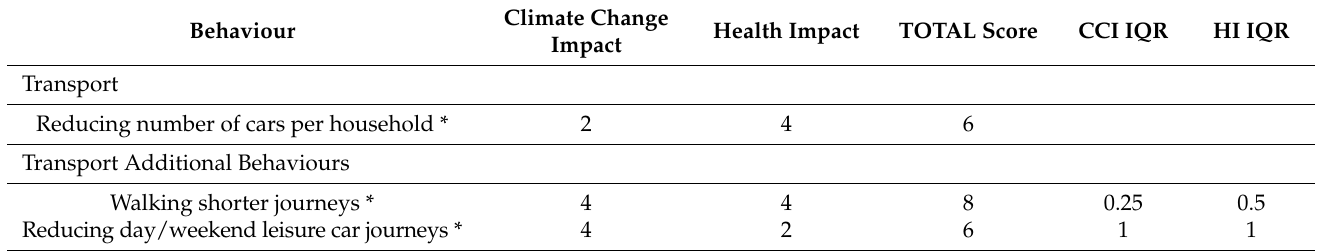
Table 4. Climate change mitigation behaviours that achieved consensus in Round 3 (including additional behaviours), climate change impact Likert importance scores, health impact criteria Likert importance scores, cumulative importance scores (TOTAL score), climate change impact IQR values (CCI IQR) and health impact IQR values (HI